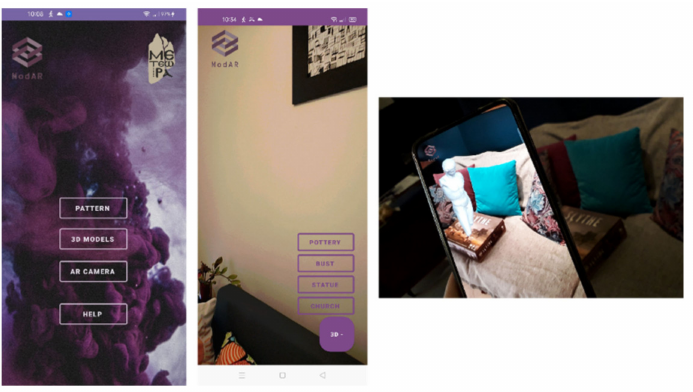
Figure 3. Main menu ( left ), list menu of camera interface ( middle ) and an AR scene ( right ) of the ModAR